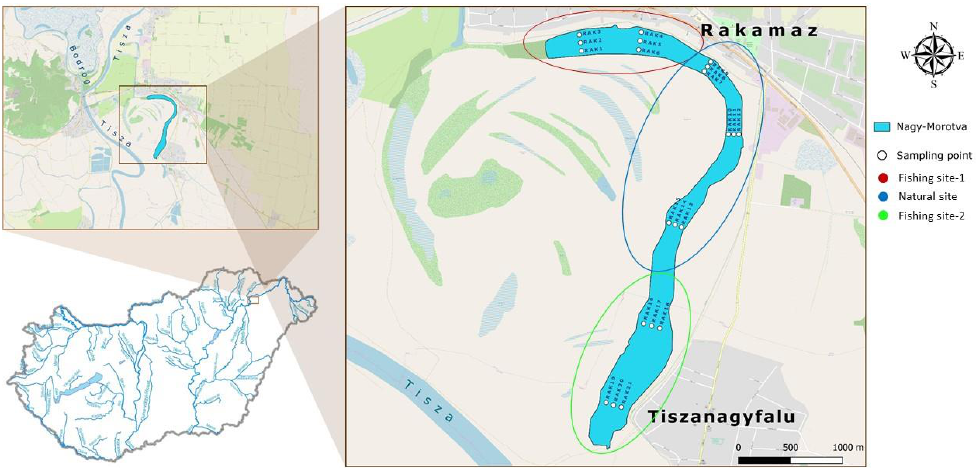
Figure 1. Area of research and sampling points in Nagy – Morotva oxbow lake.